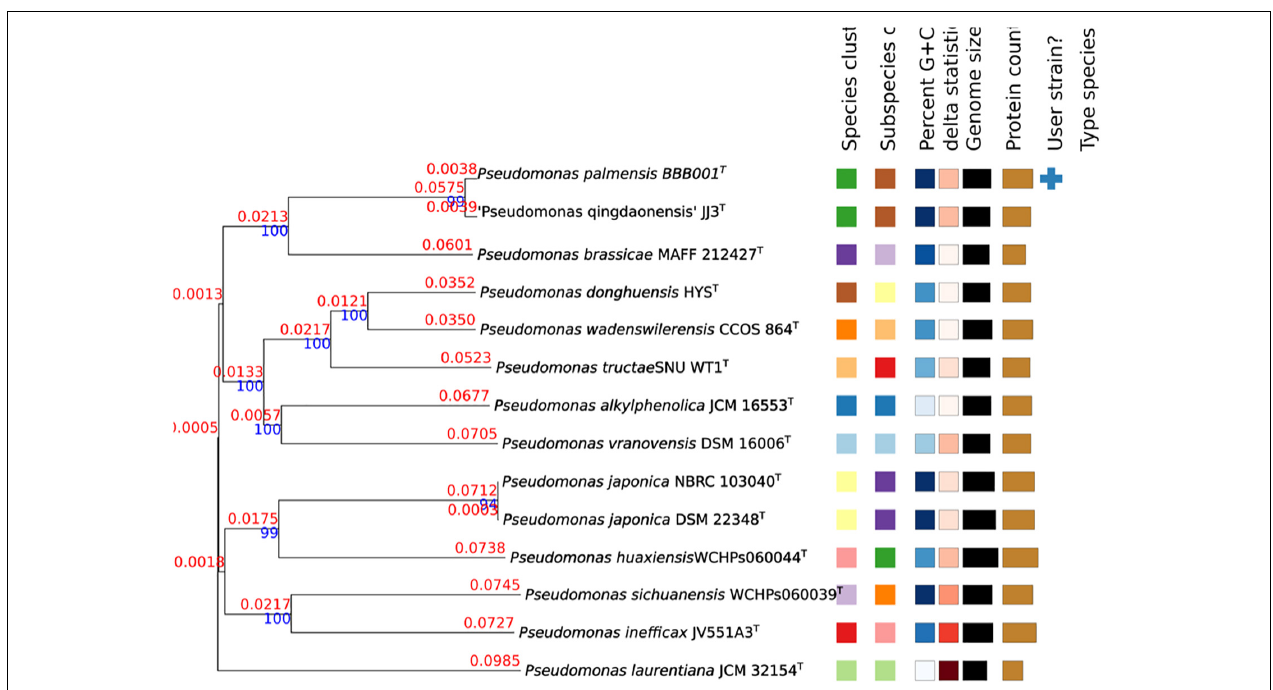
FIGURE 2 | Phylogenetic tree constructed in TYGS. Tree inferred with FastME 2.1.6.1 (Lefort et al., 2015) from GBDP distances calculated from genome sequences. The branch lengths are scaled in terms of GBDP distance formula d5. The numbers above the branches are GBDP pseudo-bootstrap support values > 60% from